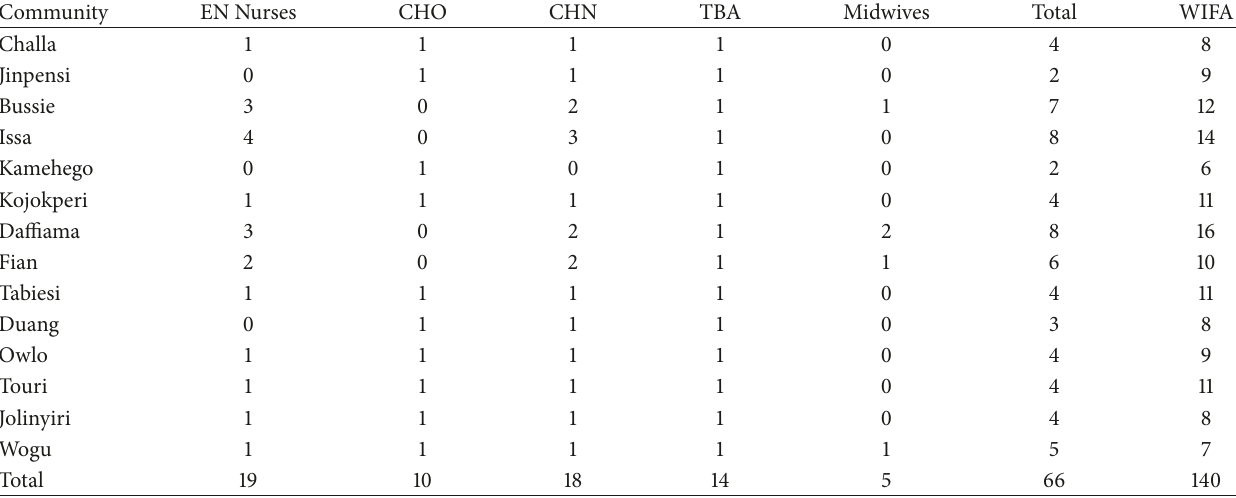
Table 1: Distribution of respondents by community and category.